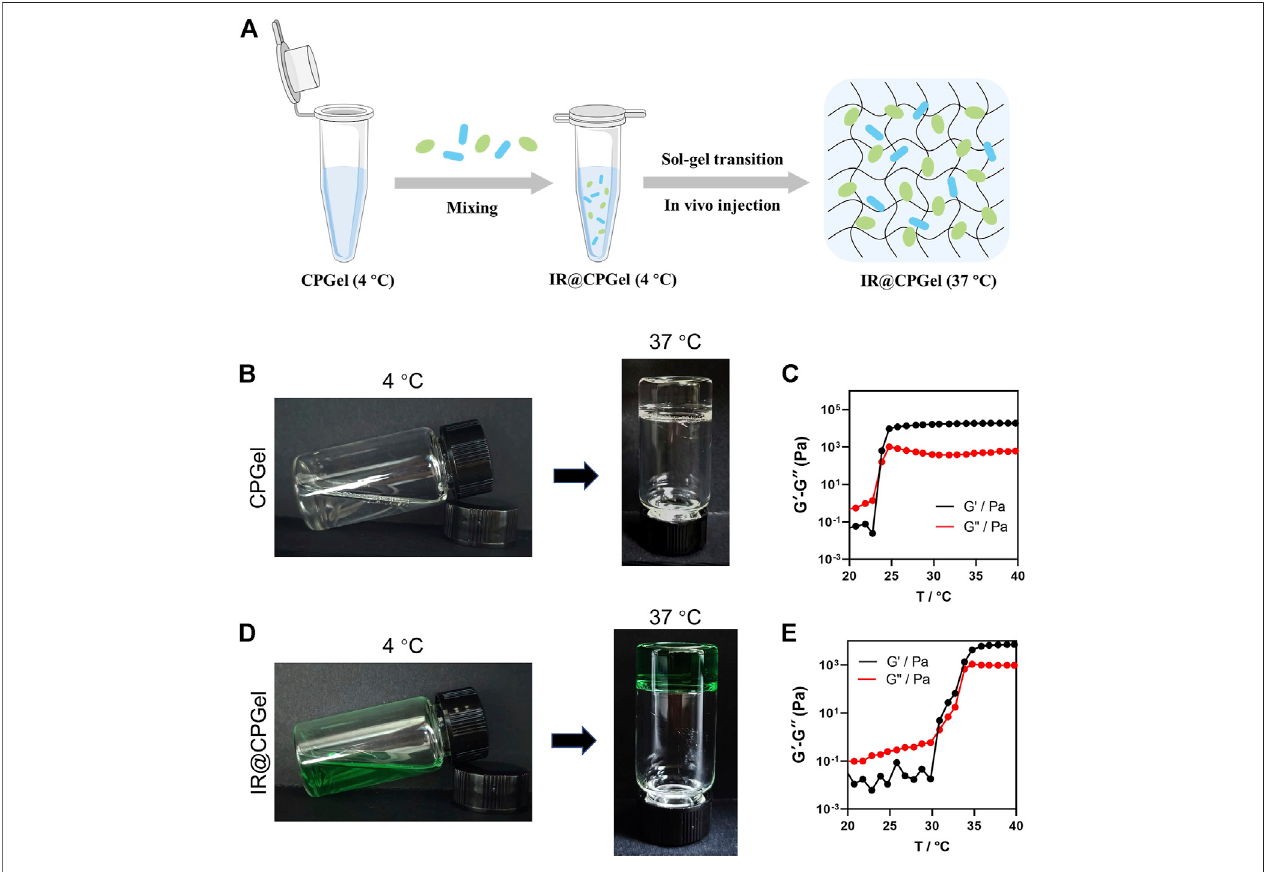
FIGURE1| PreparationandcharacterizationofIR@CPGel. (A) SchematicillustrationofproceduresforIR@CPGelpreparation; (B) representativephotosofCPGel undergoing the sol-gel transition; (C) dynamic mechanical analysis of CPGel; (D) representative photos of IR@CPGel undergoing the sol-gel transition; (E) dynamic mechanical analysis of